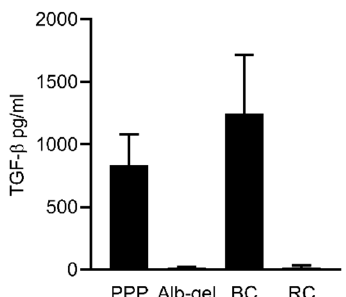
Figure 7. Concentration of active TGF- β in the all the fractions of PPP, Alb-gel, buffy coat (BC), and red clot (RC). Active TGF- β in all the prepared fractions was determined by immunoassay. Data represent the mean and standard deviation. TGF- β is indicated in pg/mL (n = 4–5).